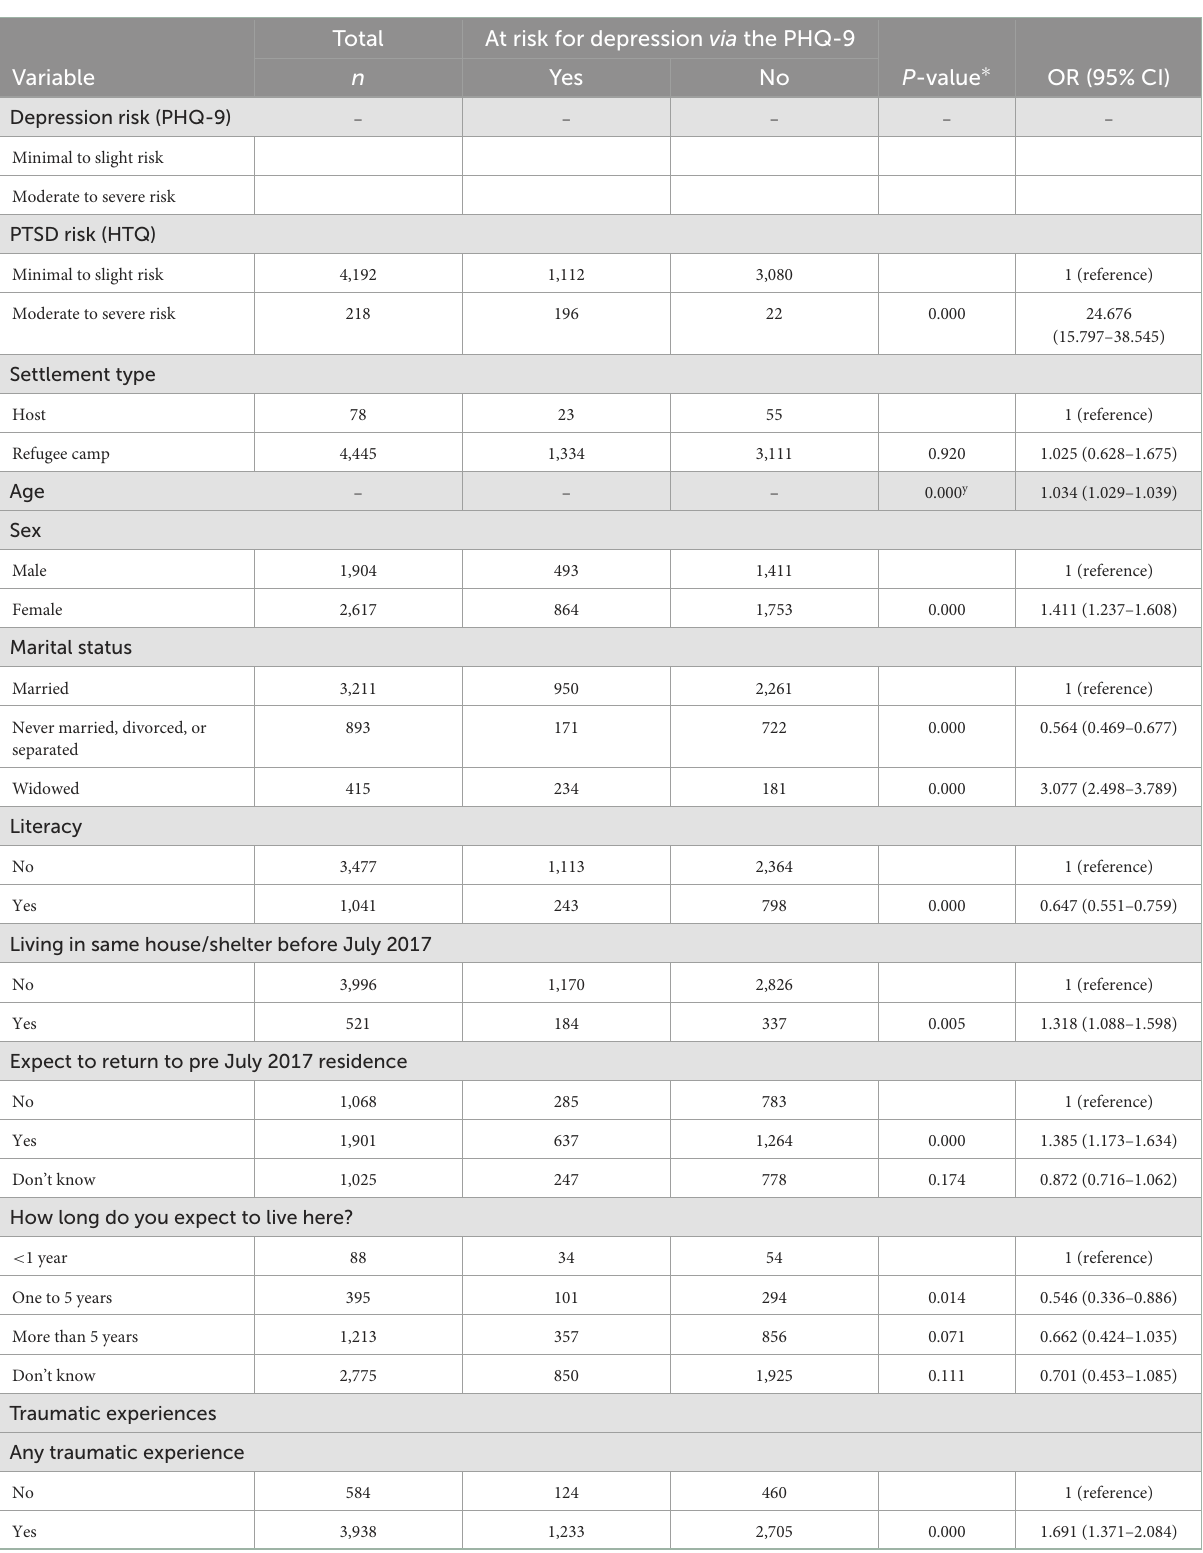
TABLE 2A Bivariable associations with depression risk in 4,523 Rohingya refugees living in Cox’s Bazar,